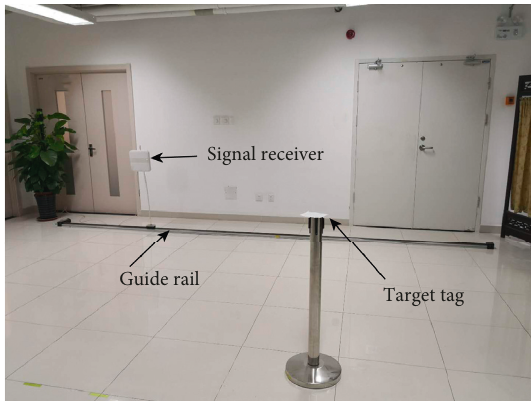
Figure 20: Motor guide rail and the signal receiver.